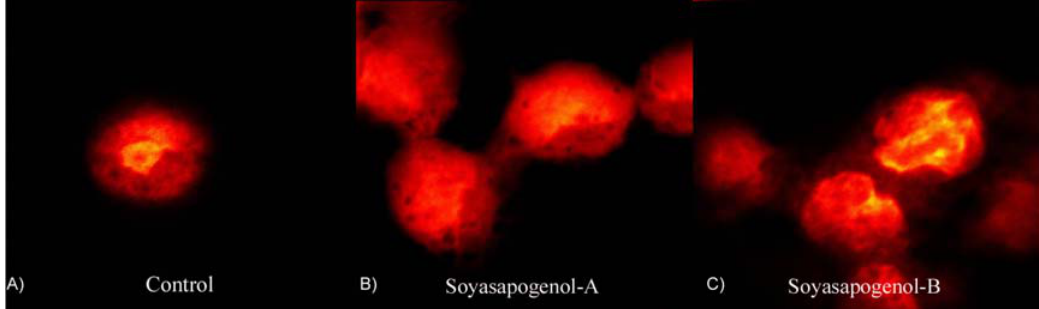
Cells were treated with soyasapogenol A (0.05 ± 0.01 mg/mL) panel (B) and soyasapogenol B (0.13 ± 0.01 mg/mL) panel (C) treated for 24 hours. Panel (A) represents untreated control cells